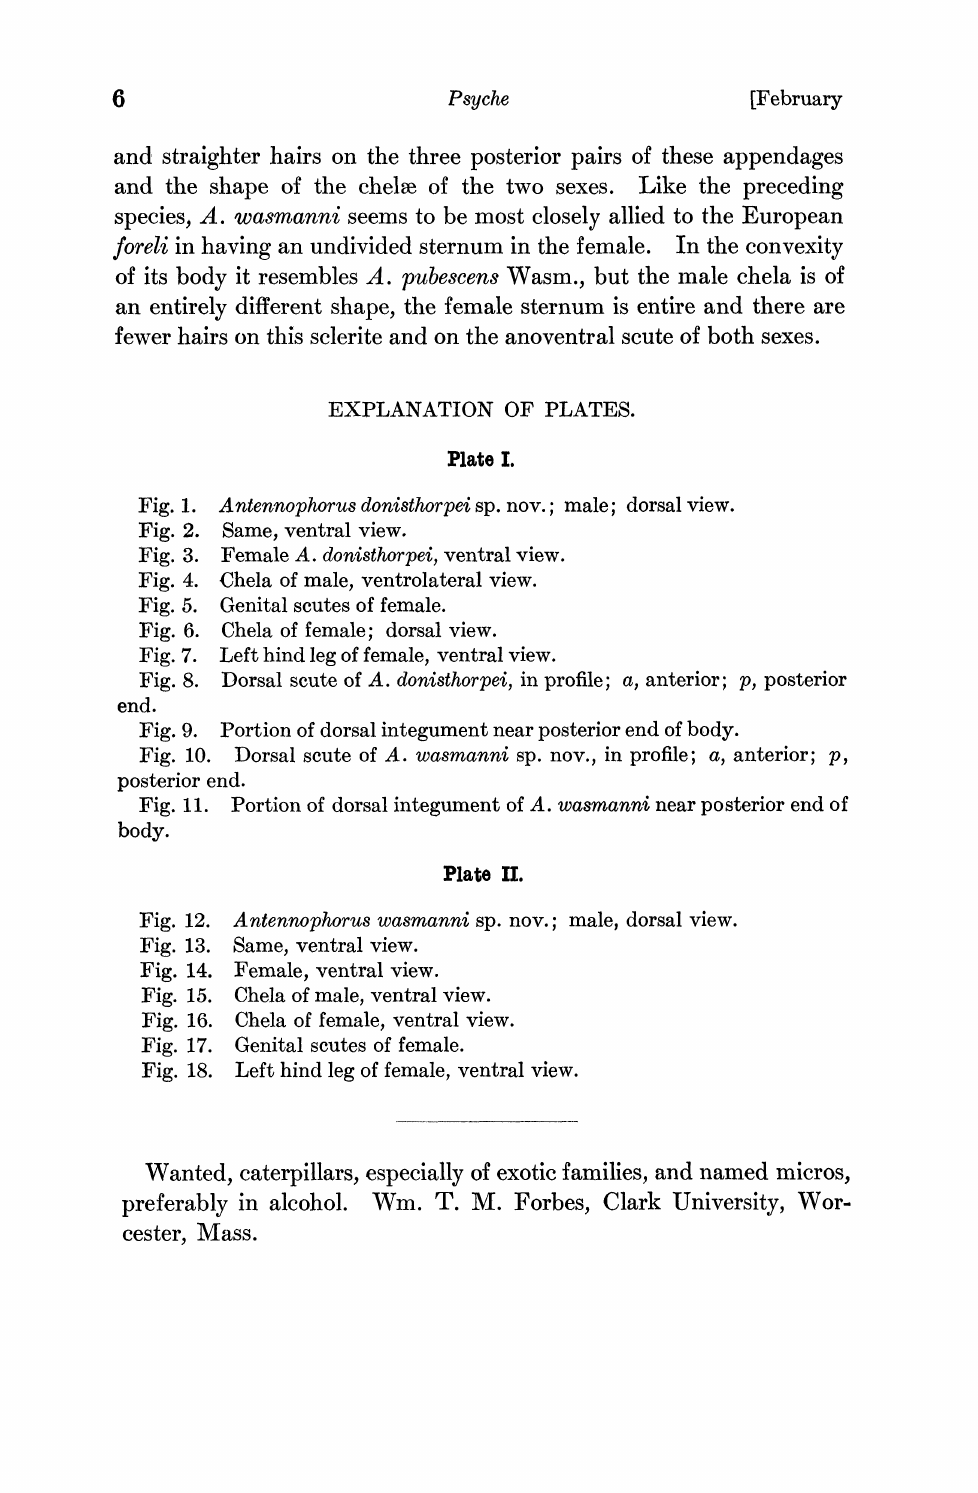
Fig. 12. Antennophorus wasmanni sp. nov.; male, dorsal view. Fig. 13. Same, ventral view. Fig. 14. Female, ventral view. Fig. 15. Chela of male, ventral view. Fig. 16. Chela of female, ventral view. Fig. 17. Genital scutes of female. Fig. 18. Left hind leg of female, ventral